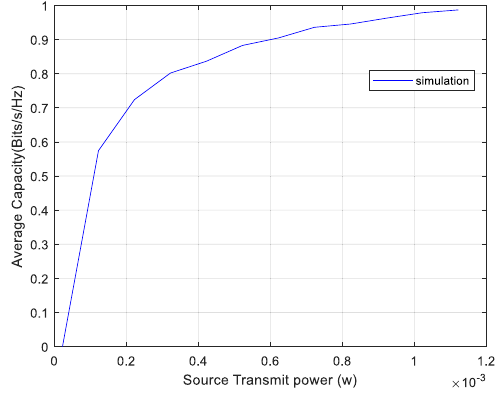
Fig. 5. Average capacity for VVLC based system with respect to source transmit power